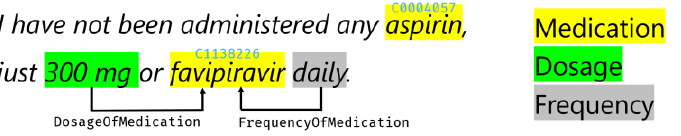
Table 1. Entity and relation types extracted by Text Analytics for Health and the number of their occurrences in the papers dataset.